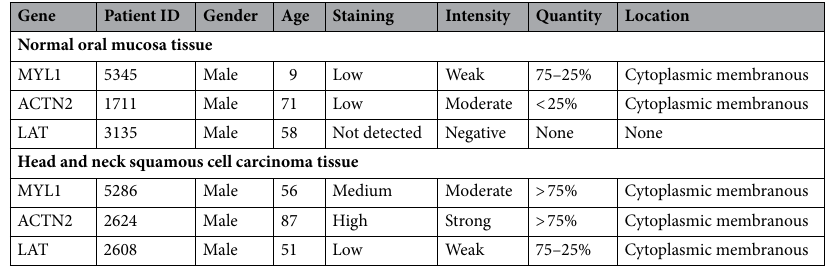
Table 3. IHC staining characteristics of genes from The Human Protein Atlas database. IHC immunohistochemistry.